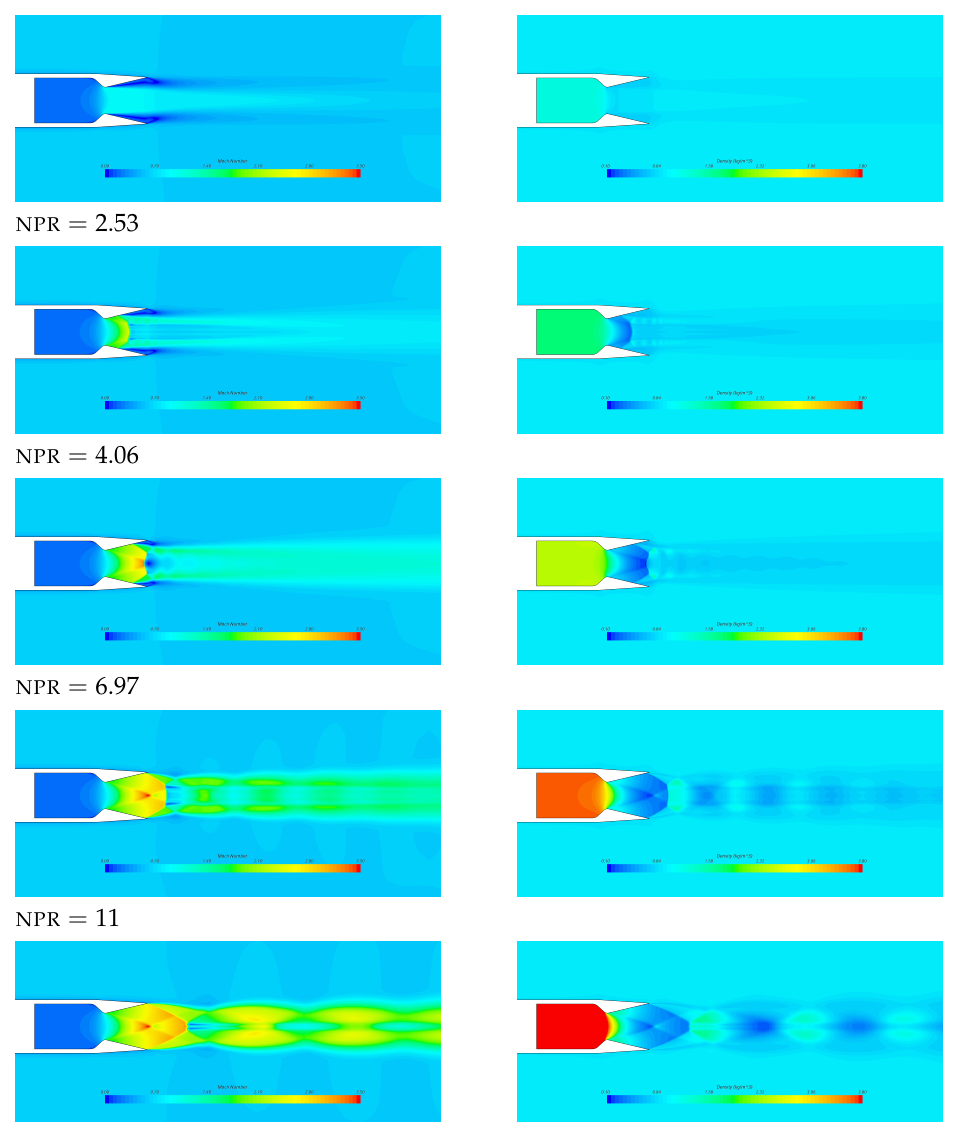
Figure 6. Mach number ( left ) and density ( right ) fields for different NPR ’s for M ∞ =